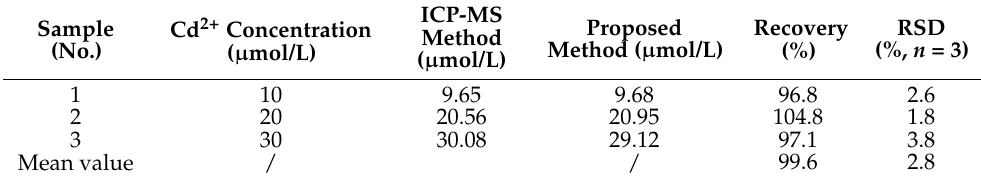
Table 1. A comparison between actual Cd 2+ concentration and the measurasdfed values, and the fluorescence restoration efficiency and relative standard deviation for the detection of Cd 2+ in the tap water.